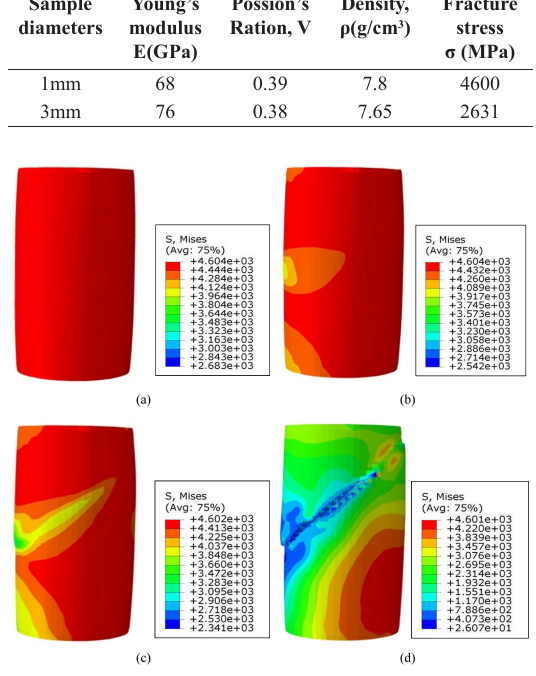
Figure 3. The stress distribution of 1mm sample at different compressive strains, a) 11.62%, b) 12.25%, c) 12.53% and d)